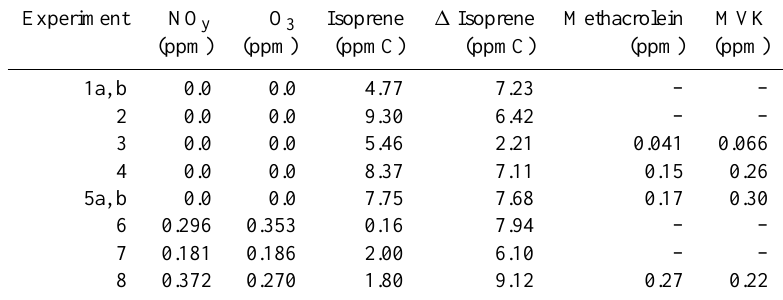
Table 2. Steady-state chamber and reacted hydrocarbon concentrations for flow-mode experiments. Experiment NO y O 3 Isoprene 1 Isoprene